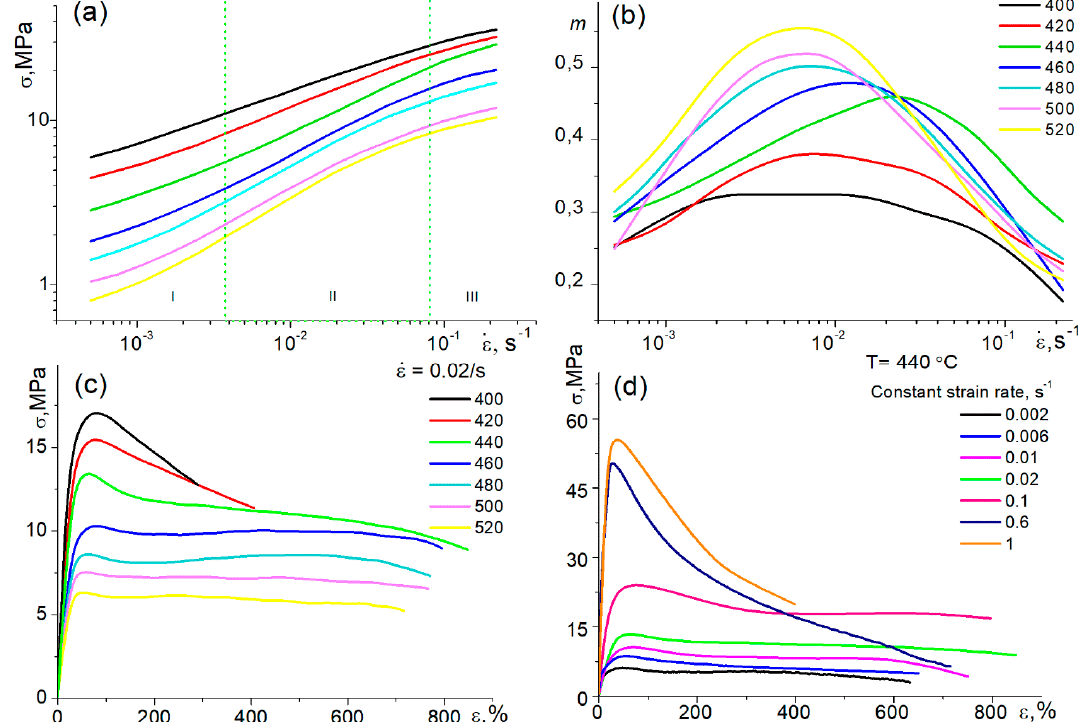
Figure 2. ( a ) Stress–strain rate logarithmic curves and ( b ) strain rate sensitivity m-index-strain rate semilogarithmic curves in a temperature range of 400 to 520 °C (the samples were pre-deformed to 0.69 at a constant strain rate of 0.002 s − 1 at each temperature); ( c ) stress–strain curves at a range of 400 to 520 °C and a constant strain rate 0.02 s − 1 ; ( d ) stress-strain curves at a temperature of 440 ° С and different strain rates .